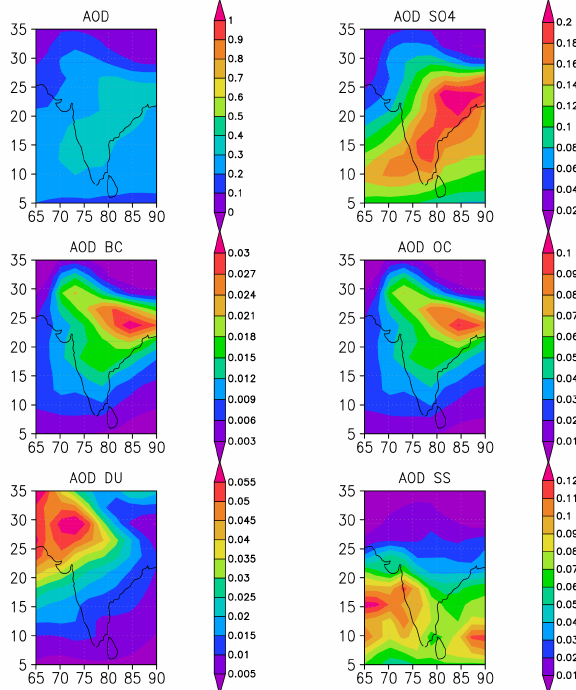
Fig. 3. Total AOD in India and contributions to it from different aerosol species (four-year average (2006–2009),